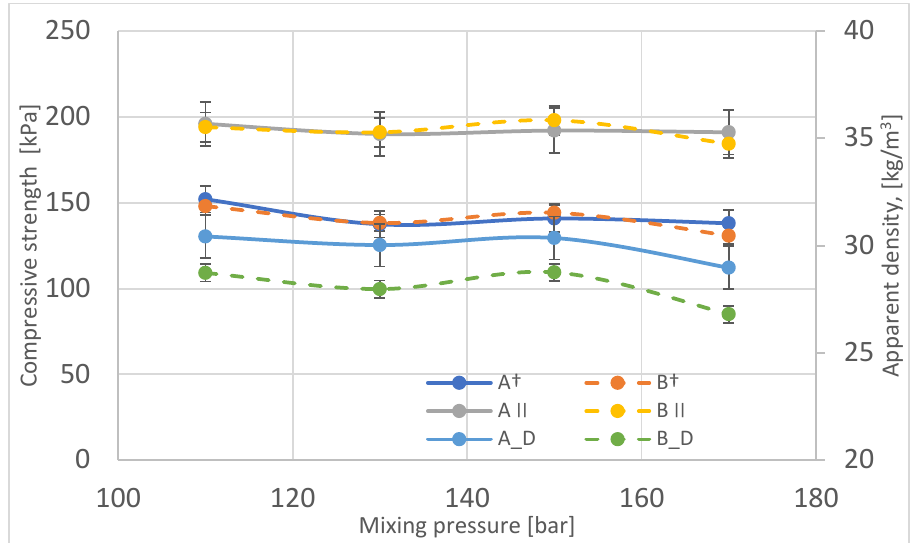
Figure 12. Variation of compressive strength as a function of mixing pressure in the perpendicular (A†, B†) and parallel directions (A ||, B ||) compared to changes in apparent density of foams (A_D, B_D). Table 5. Variation in compressive strength between foam samples taken from different